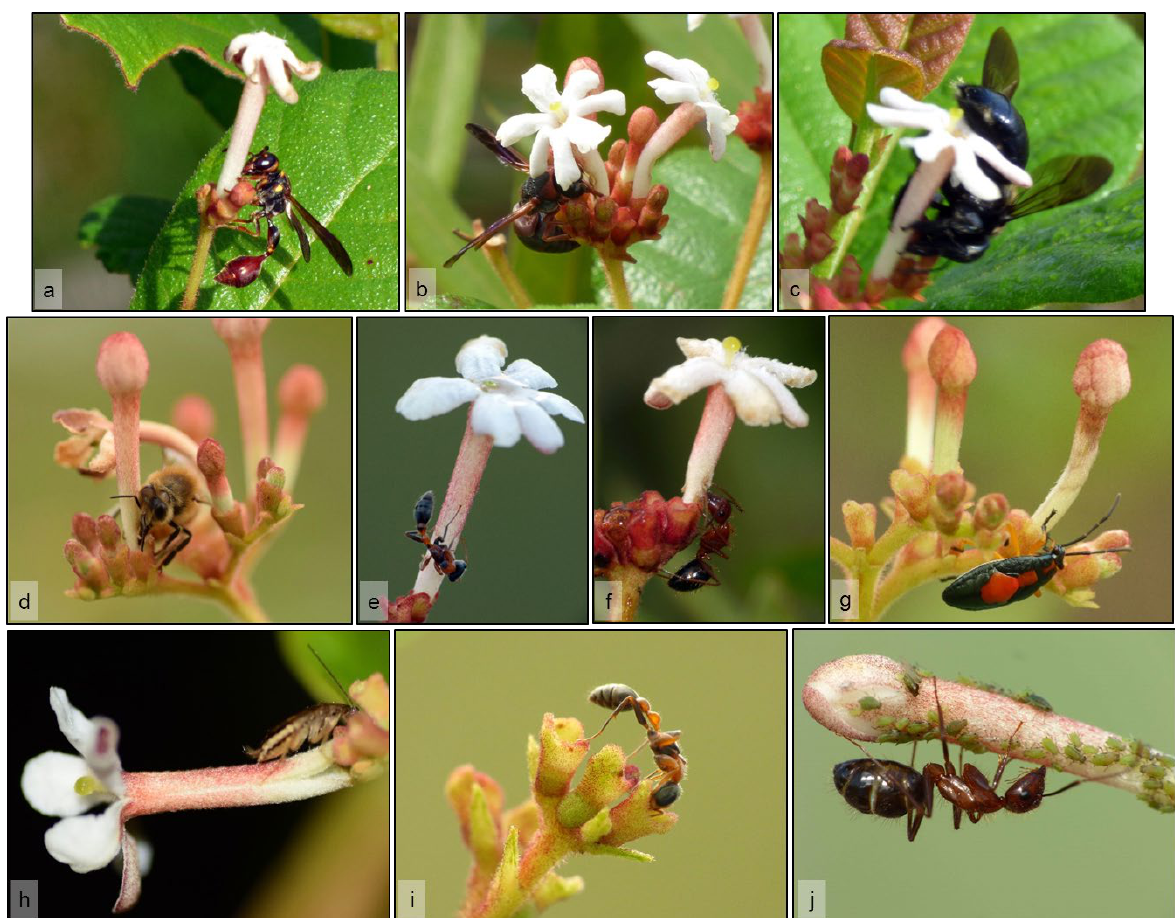
Figure 5. Overview of nectar robbers found on flowers of Guettarda scabra in pine rockland habitats in south Florida, USA. Diurnal primary nectar robbers such as the wasps ( a ) Zethus slossonae , ( b ) Stenodynerus sp., and the bee ( c ) Xylocopa micans use their mandibles to pierce the base of the corolla to access the nectar. Notice how the hairy underside of the abdomen in X . micans comes in close contact with the stigma of the flower, as the bee cuts the corolla tissue, potentially leading to pollen transfer. Secondary nectar robbers such as the honeybee ( d ) Apis mellifera , the ants ( e ) Pseudomyrmex gracilis and ( f ) Camponotus floridanus , the true bug ( g ) Largus succinctus (nymph), and ( h ) a cockroach ( Blattodea sp.), drink nectar through holes cut at the base of the corolla tube by a previous visitor. Opportunistic ant visitors such as P . gracilis can also feed on nectar from postfloral nectaries ( i ) or as observed in C. floridanus , feed on honeydew secreted by aphids ( j ).